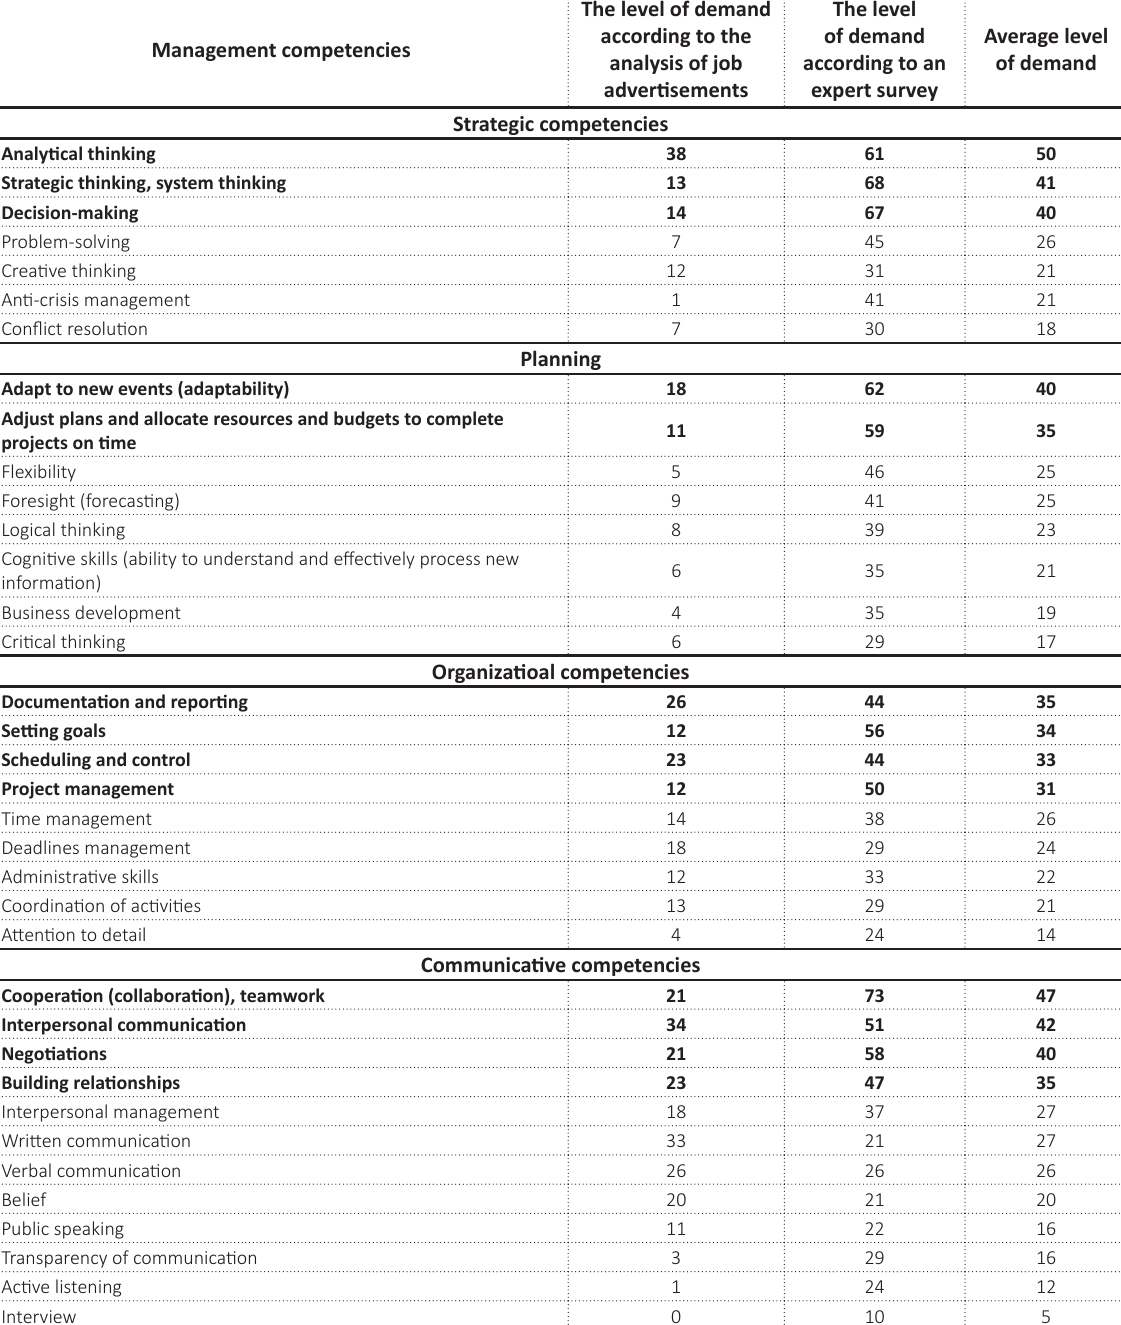
Table A5 (cont.). The level of demand for management skills among employers in Ukraine,